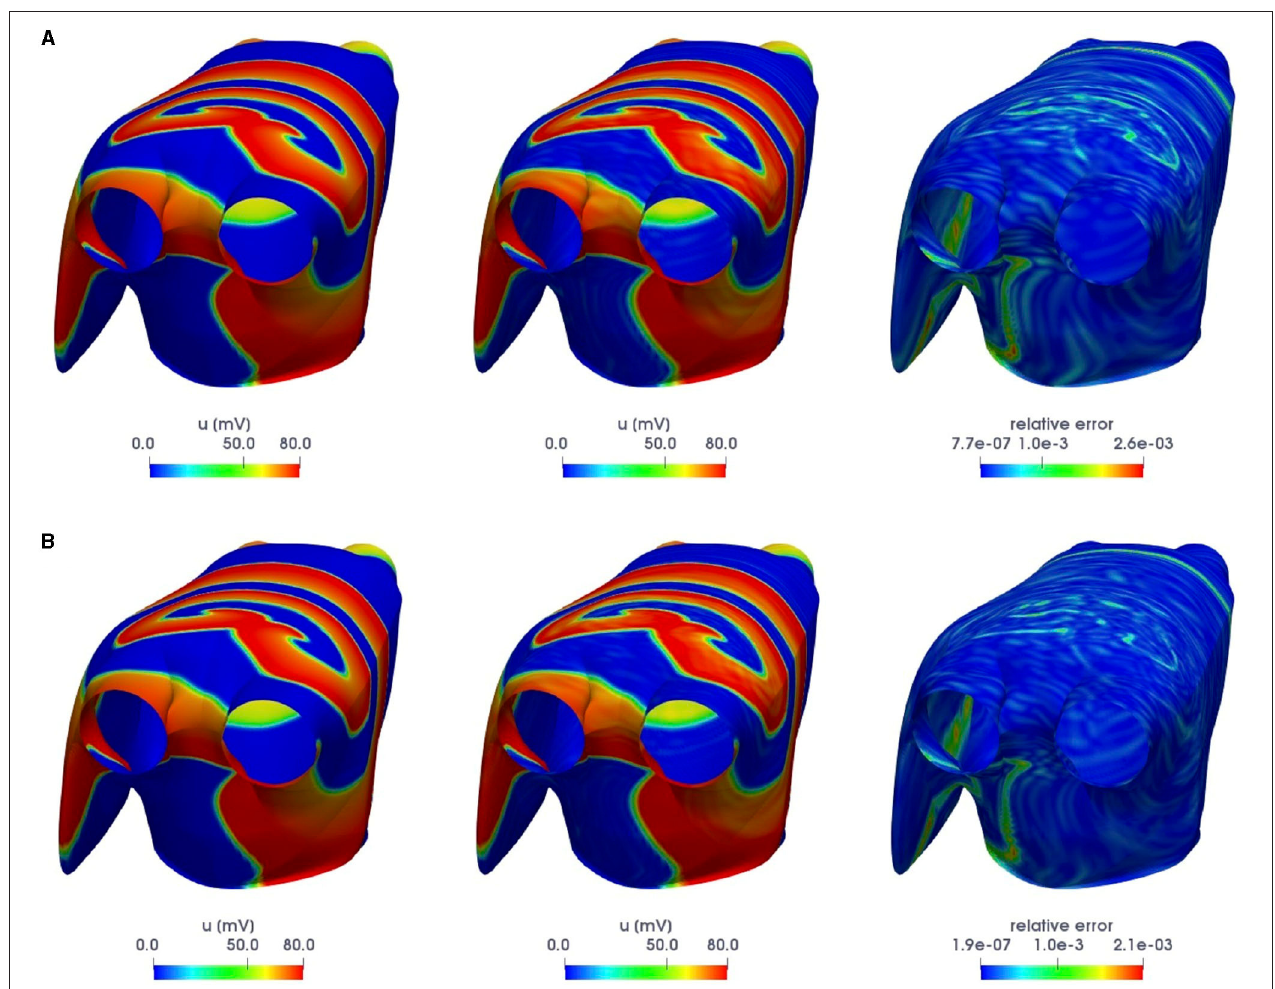
FIGURE 9 | Test 3 : FOM (left) and POD-DL-ROM (center) solutions, the latter obtained with n = 4 and N = 256 (A) , and n = 4 and N = 1,024 (B) , together with ǫ k (right), for the testing-parameter instance µ